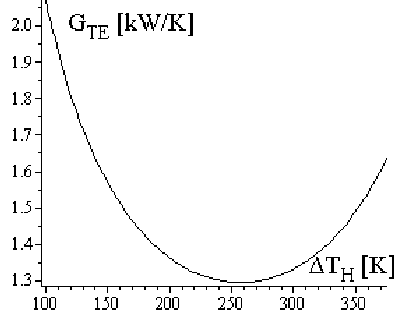
Figure 15. G TR dependence of Δ T R —case “a”. G TRmin = 2.975 kW/K for Δ T R = 6.72 K.